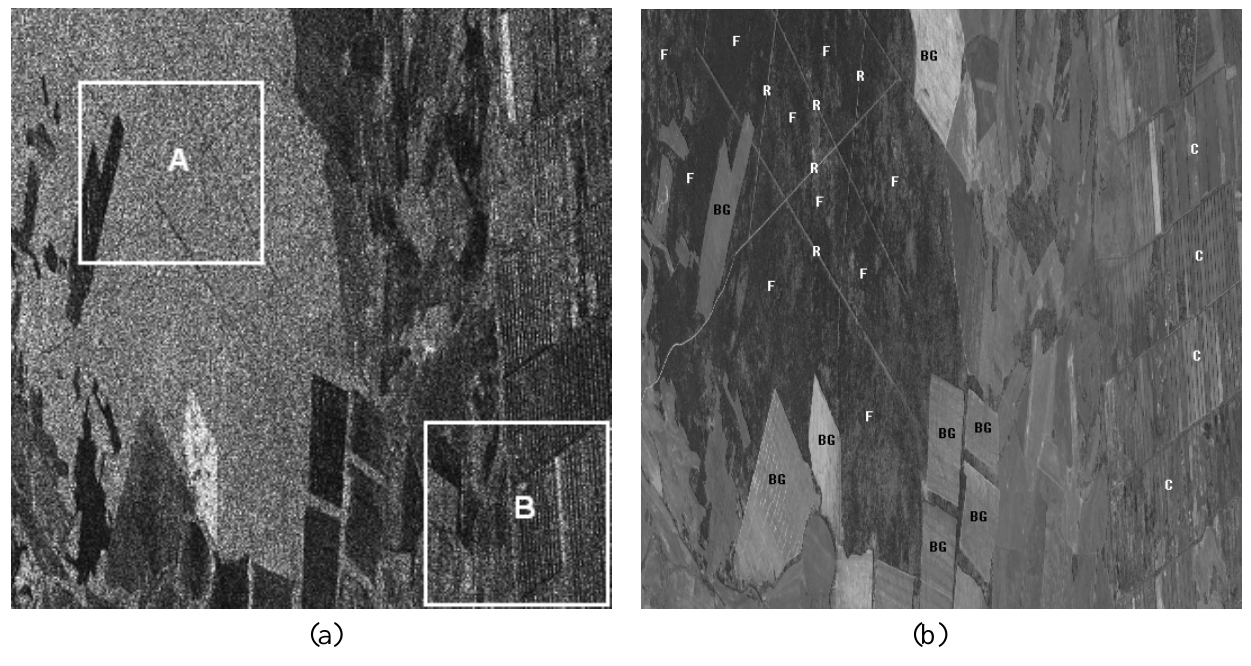
Figure 2. (a) The amplitude image in HH channel of the vegetation and bare ground test area. The typical targets in Frame A and B are forest and bare ground, cropland, respectively. (b) The corresponding optical image from Google Earth. F, R, GB and C indicate forest, road, bare ground and cropland,